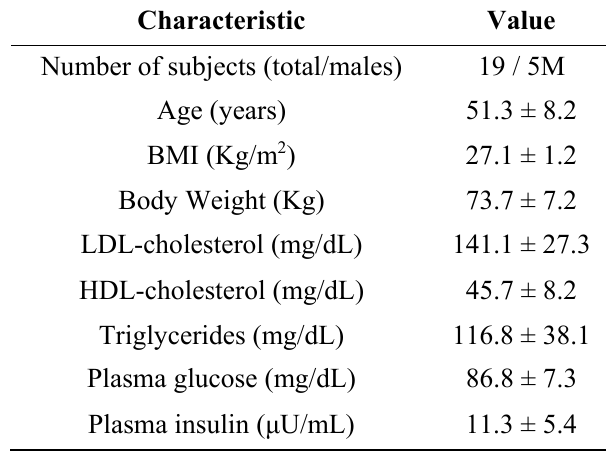
Table 2. General characteristics of the study population (mean ±